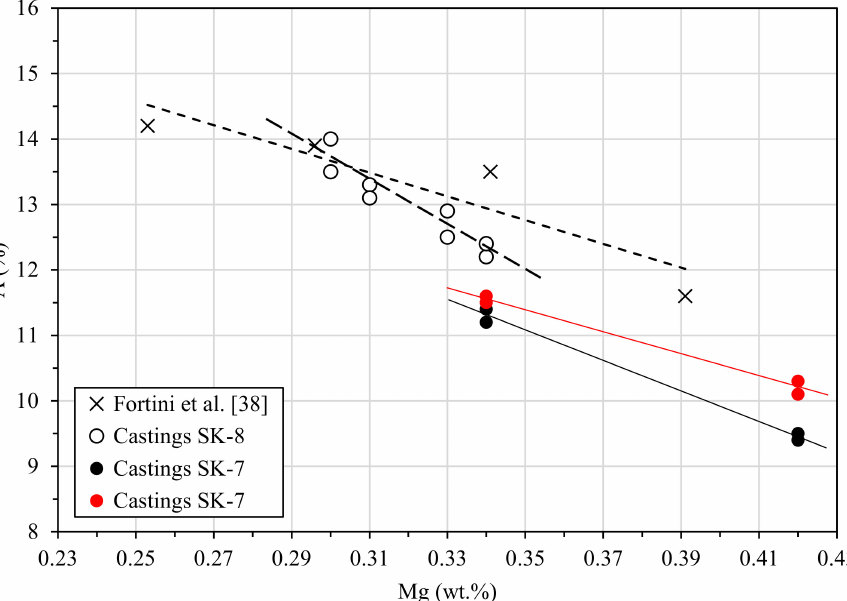
Figure 17. Evolution of A with Mg content for the series of A356 alloys reported by Fortini et al. [38] aged at 155 ◦ C for 270 min (crosses), from areas A1 and A2 in castings SK-7 aged at 165 ◦ C for 280 min (gray solid circles), for 360 min (black solid circles) and from areas A1 and A2 in castings SK-8 aged at 155 ◦ C for 360 min (open